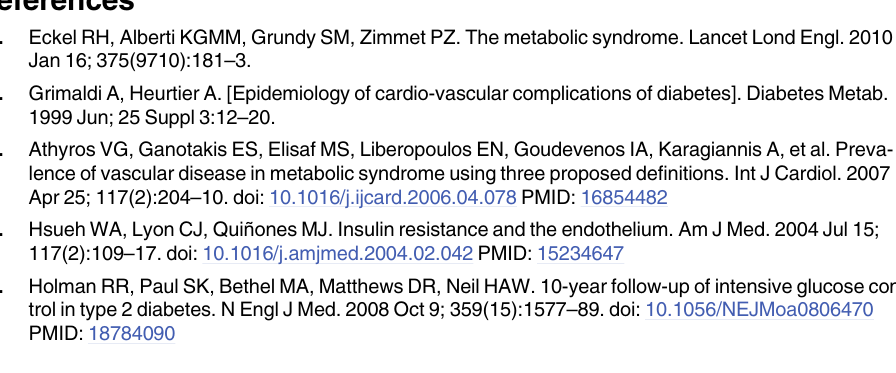
S1 Table. A1c and minimal luminal area